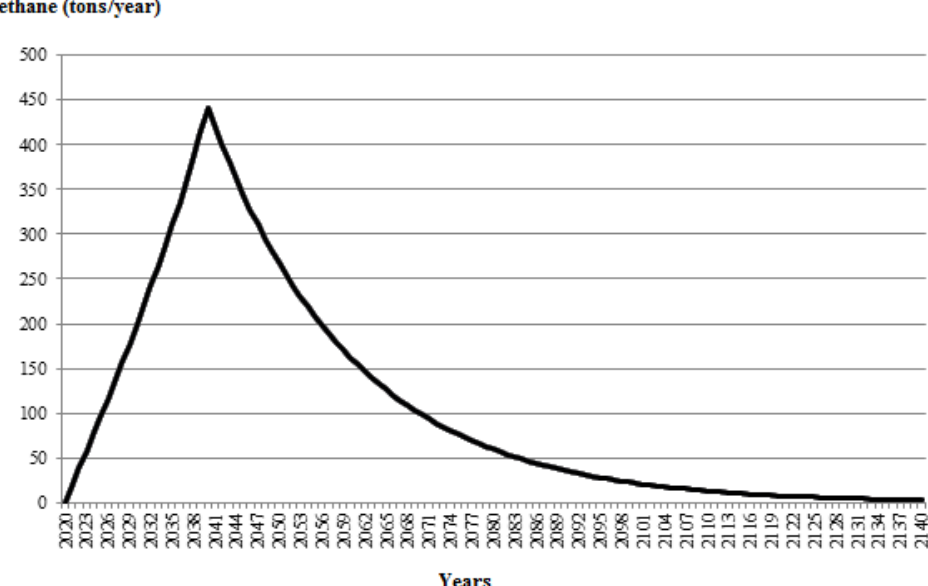
Figure 2. The methane production profile of the Edirne solid waste landfill facility